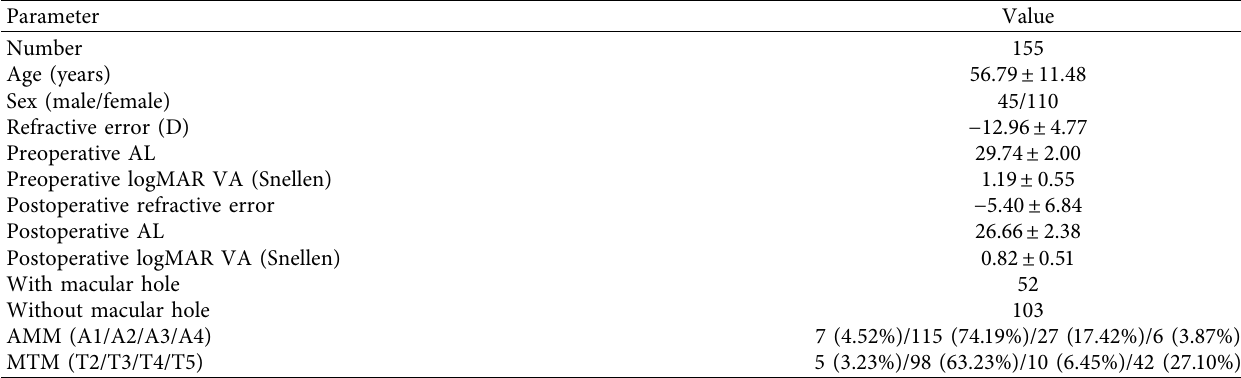
Figure 1: Presurgery and postsurgery OCT images of patients with MH and MD. (a) Presurgery image of MH and MD. (b) Image of MH closure at 23-month follow-up postsurgery. (c) Presurgery image showing MH, foveoschisis, and MD. (d) Image showing retinal reat- tachment but not MH closure at the 25-month follow-up postsurgery. MD � macular detachment, MH � macular hole, and OCT � optical coherence tomography. Table 1: Demographics and characteristics of the patients with myopic foveoschisis at baseline visit.